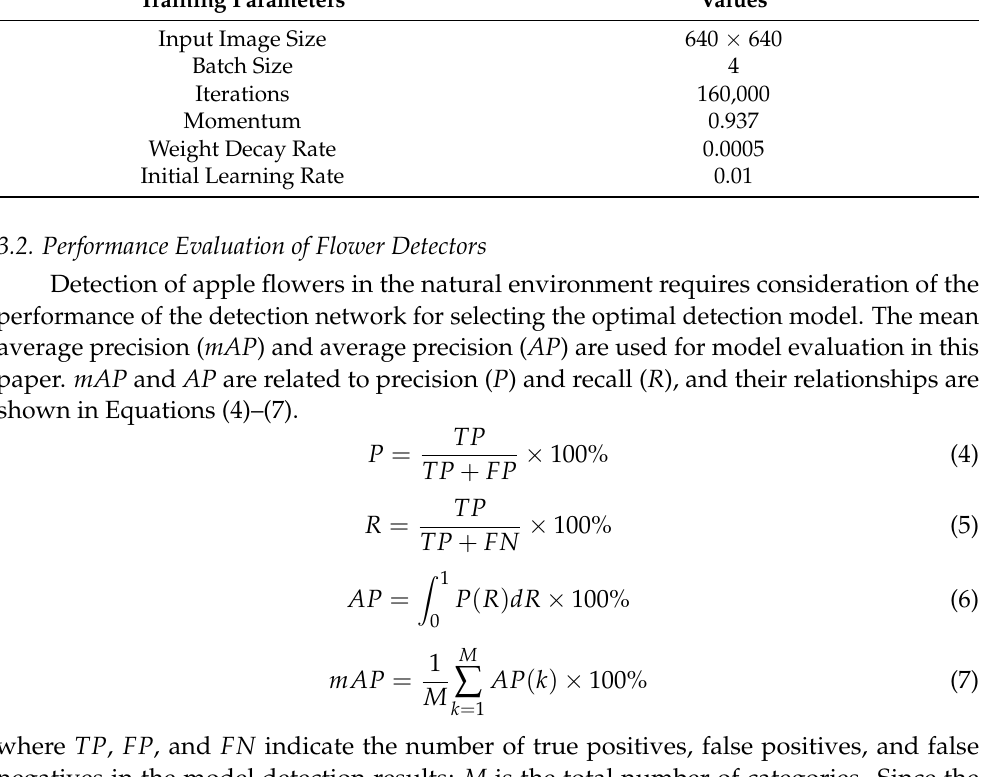
Table 2. Model training parameters. Training Parameters